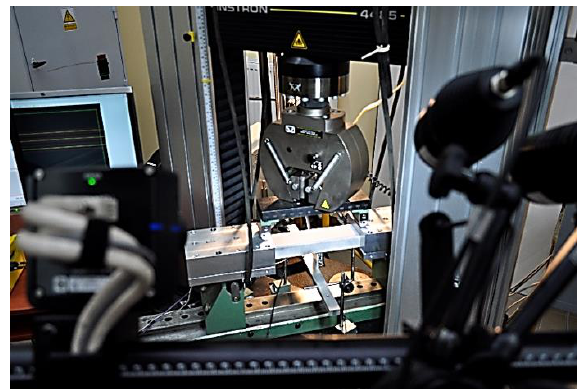
Figure 4. Test stand for four-point bending test.